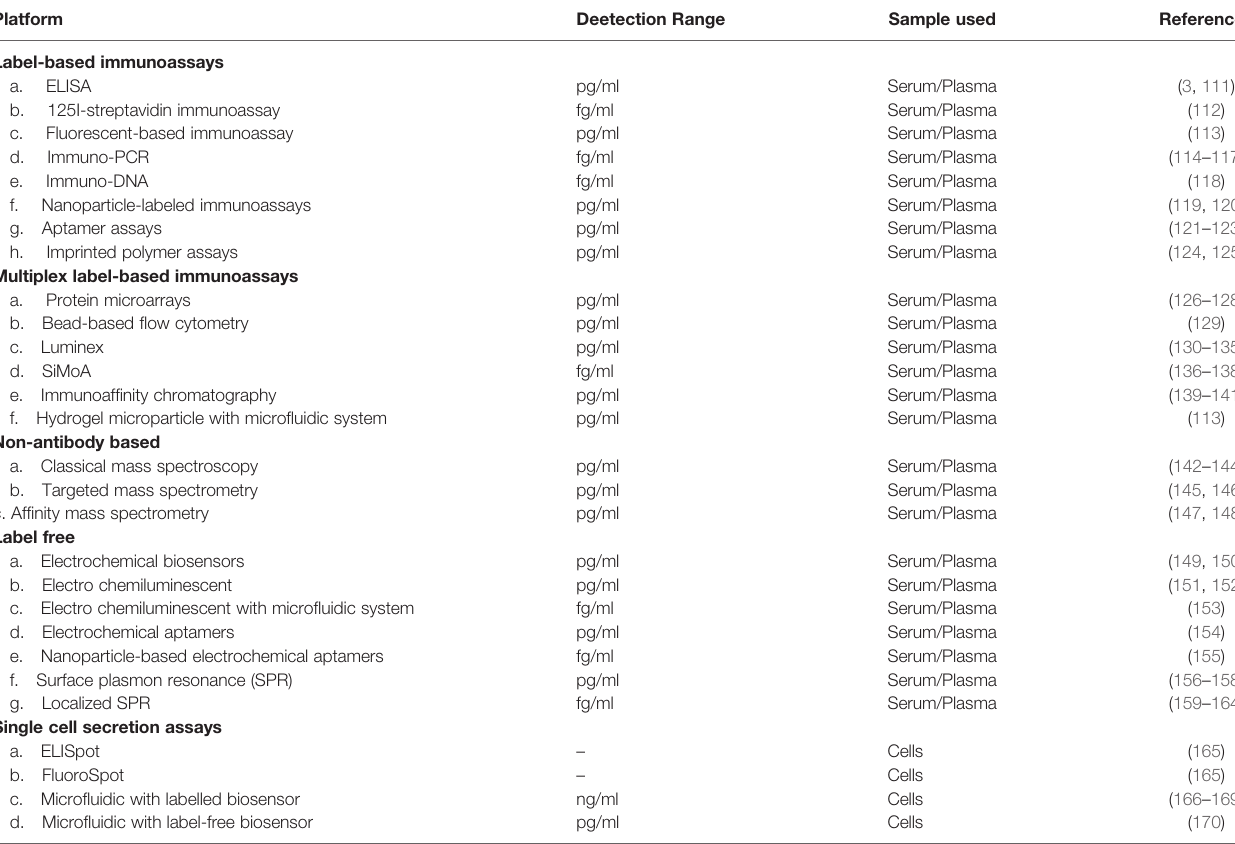
TABLE 1 | Established and emerging devices for cytokine